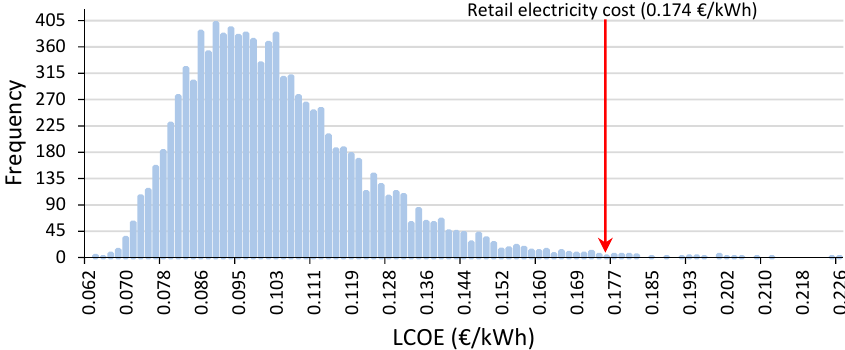
Figure 12. Histogram of the LCOE calculated with the Monte Carlo method for a 50 kW system.